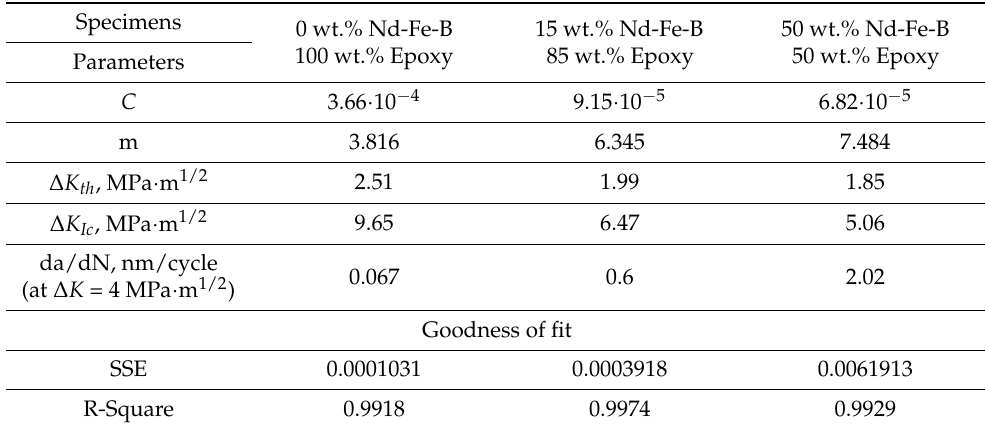
Table 2. The parameters of fatigue crack